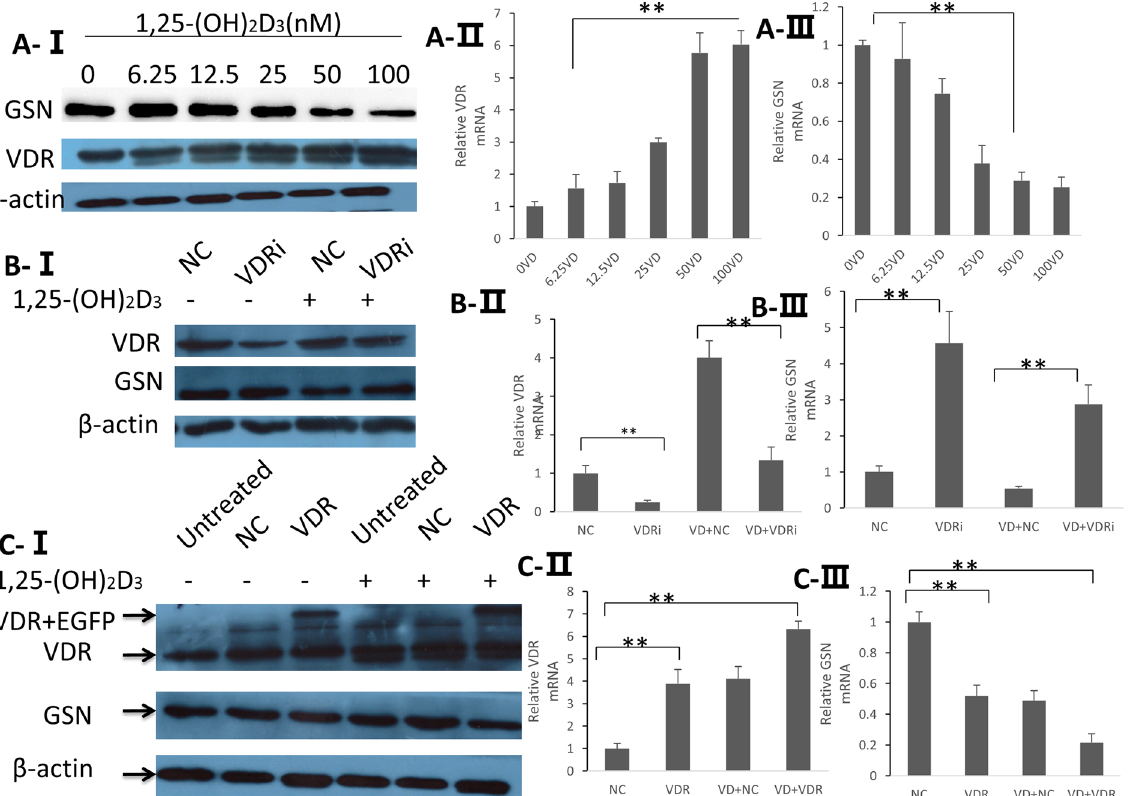
2 D 3 (0, 6.25, 12.5 25, 50, and 100 nmol/L) for 72 h. A-II, A-III the mRNA levels were examined by real-time PCR. B , PC12 cells stimulated for 24 h with or without 1,25-(OH) 2 D 3 (50 nmol/L) following transfection with the VDR plasmid (GV230) or control (NC) plasmid. B-I , Western blot results of VDR and GSN levels, the blots are cropped; the uncropped full-length gels are presented in the Supplementary Figure (Fig. S1A). B-II, B-III , Real-time PCR tested the changes of VDR and GSN in the mRNA level. C-I , Western blot analysis of VDR interference in PC12 cells following injection of the VDR lentiviral expression vector (with EGFP gene) and control lentiviral expression vector. PC12 cells were stimulated with or without 1,25-(OH) 2 D 3 (50 nmol/L) for 24 h before injection of VDR lentiviral expression vector and control lentiviral expression vector. C-II, C-III , Real-time PCR tested the changes of VDR and GSN in the mRNA level. * p < 0.05 (one-way